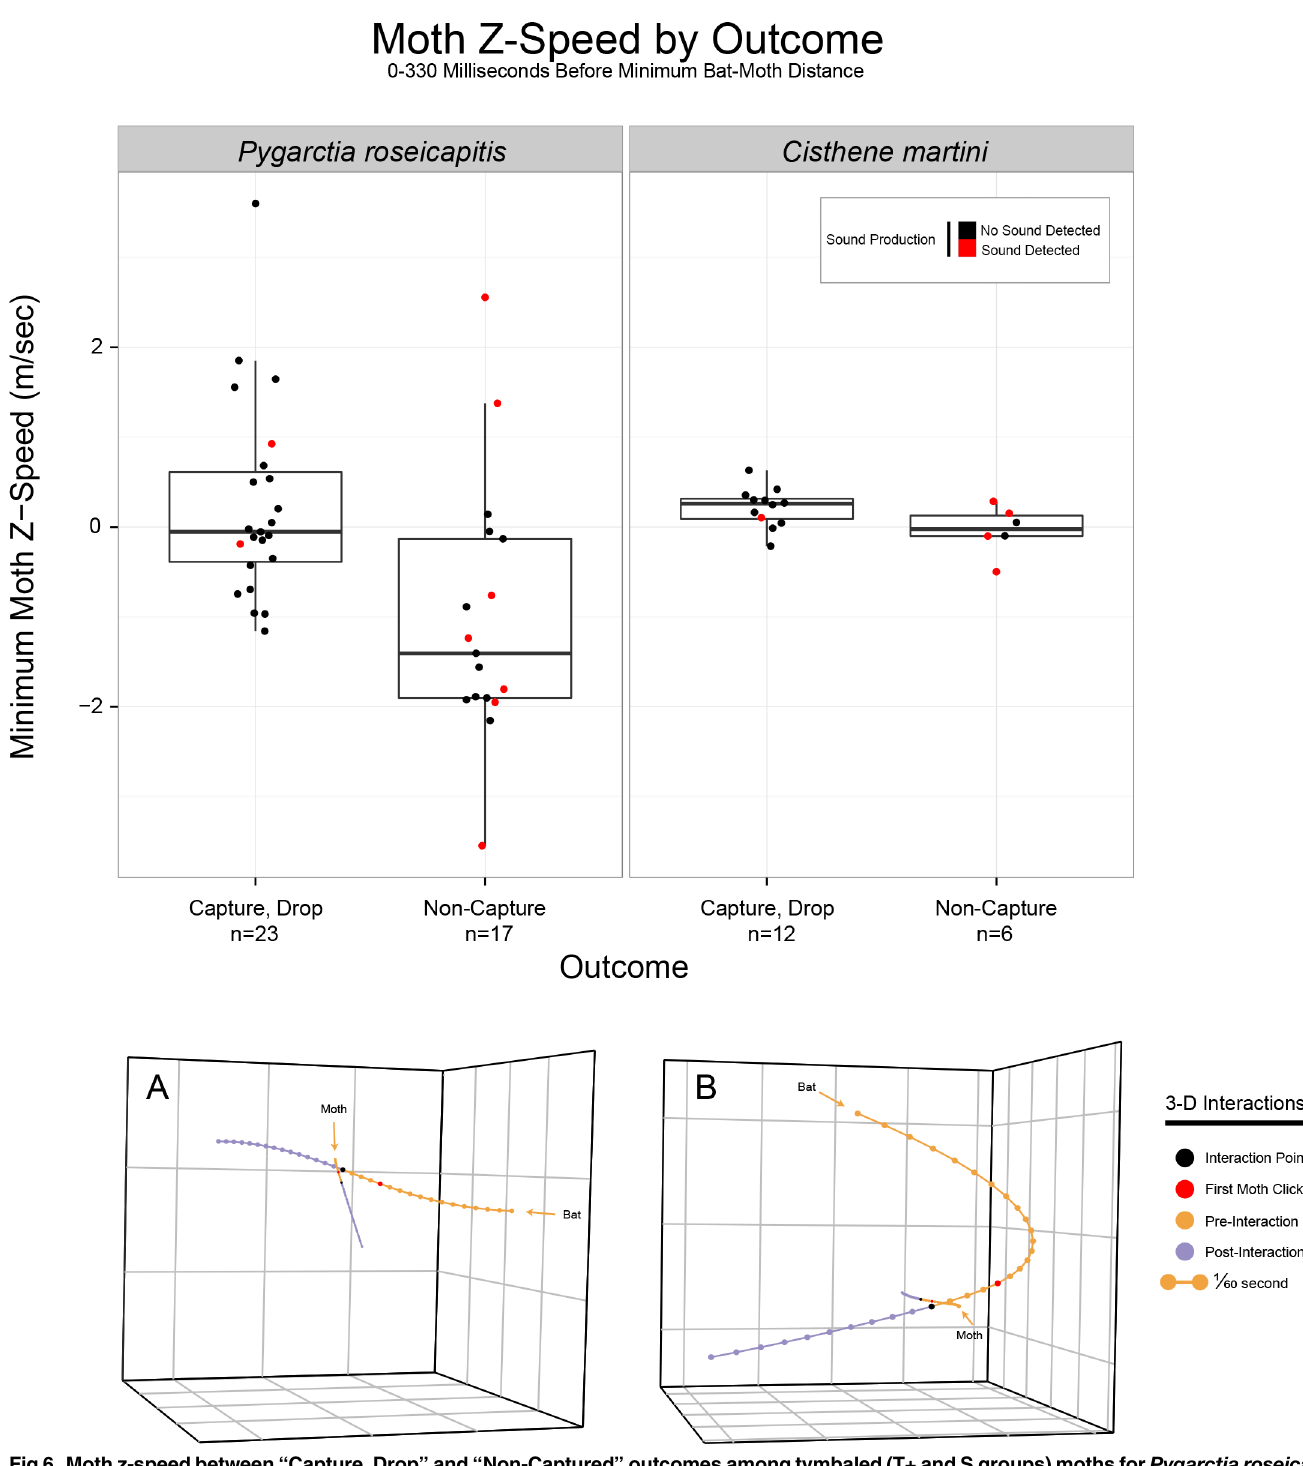
Fig 6. Moth z-speed between “ Capture, Drop ” and “ Non-Captured ” outcomes among tymbaled (T+ and S groups) moths for Pygarctia roseicapitis and Cisthene martini . Boxplot follows plotting conventions in Fig 3. The speed of the moths in the z-axis acts as a proxy for detecting diving evasive behavior. Positive values are upward flight, values near 0 m * sec -1 are level flight, and negative values are downward flight. Only P . roseicapitis which were not captured were significantly different from 0 m * sec -1 , indicating that that species employed evasive dives. Neither outcome involving C . martini was significantly different from 0 m * sec -1 , indicating that this species did not frequently employ evasive dives. 3-D perspective plots display representative flight path data. Bats are depicted as larger points and moths as smaller points. Starting points are indicated by an arrow. Time flows from Yellow (Pre-Interaction)